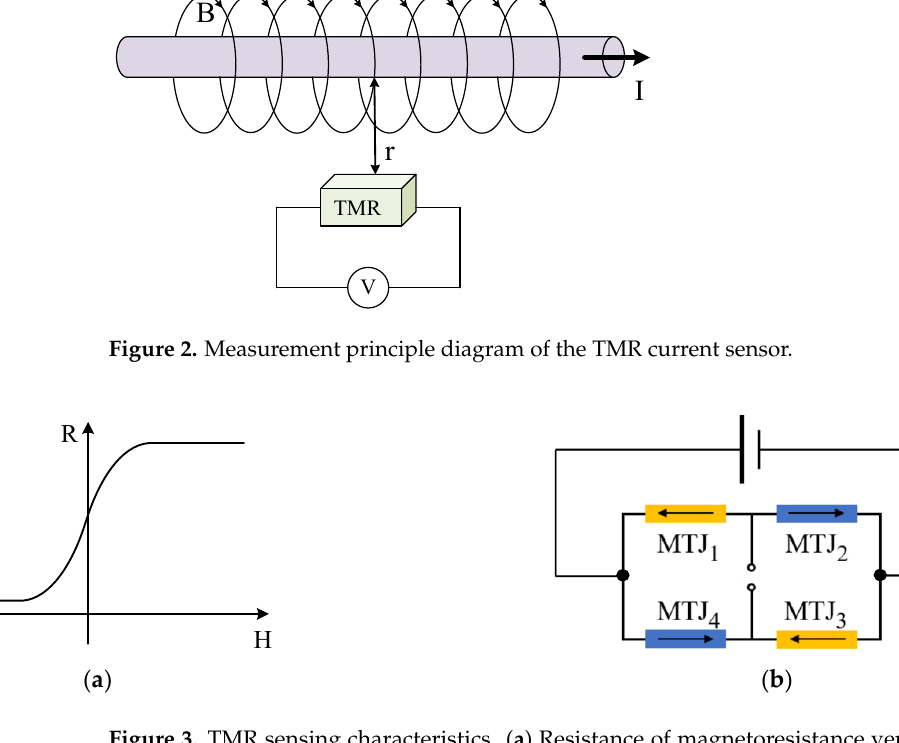
( b ) Figure 4. Structure of the TMR sensor. ( a ) Internal parasitic capacitance of the TMR sensor, ( b ) in- ternal equivalent structure of the TMR sensor. It can be seen from Figure 4b and Formula (3) that the output voltage signal of each TMR sensor is proportional to the measured current below the cutoff frequency. The cut- off frequency is defined by the resistance and parasitic capacitance of the TMR element. Therefore, adding parallel resistors to the differential output of the TMR sensor can in- crease the bandwidth, but the disadvantage of this method is that it reduces the sensitivity of the sensor. 2.2. Measurement Principle of the Planar PCB Roche Coil Current Sensor The planar PCB Rogowski coil has the advantages of measurement, high precision, good linearity, and high-frequency performance [22]. The planar PCB type Rogowski coil structure, as shown in Figure 5, ( ) i t is the current to be measured of the current overload current conductor, a and b are the inner diameter and outer passage of the coil, r is the distance from the center of the current carrying conductor on the PCB, h is the height of the PCB board, and N is the number of turns of the coil. Therefore, the total flux through the PCB conductive trace is: